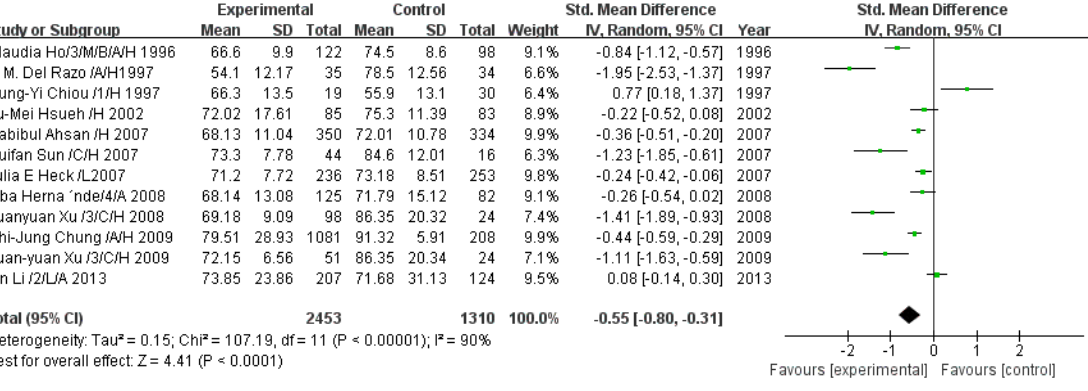
Figure 8. Effect of arsenic exposure on dimethyl arsenic percentage (DMA%) in urine. Std, standardized; SD, standard deviation; IV, independent variable; CI, confidence interval